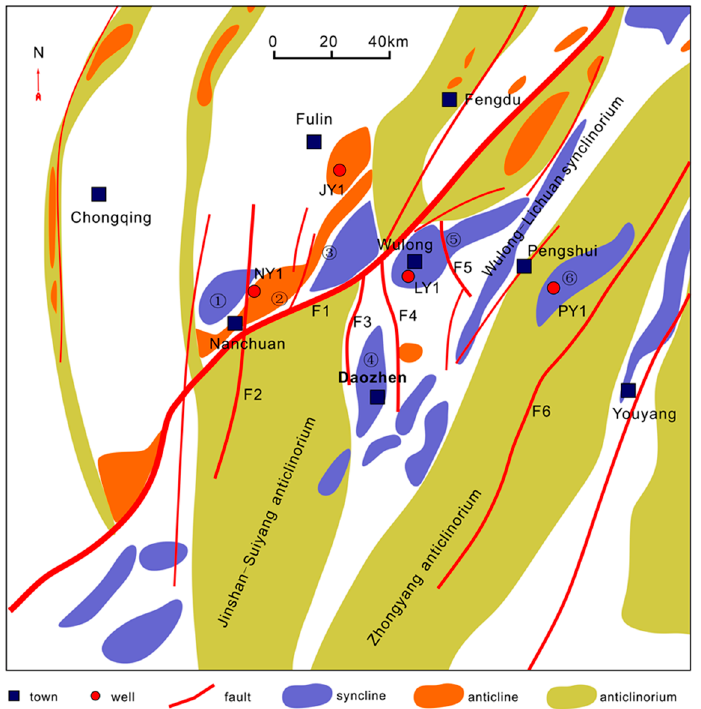
Figure 3. Plane distribution of the main faults in the study area (F1: Qiyueshan fault, F2: Longjiqiao fault, F3: Daqian fault, F4: Chayuan fault, F5: Hujiayuan fault, F6: Pengshui–Jianshin fault).